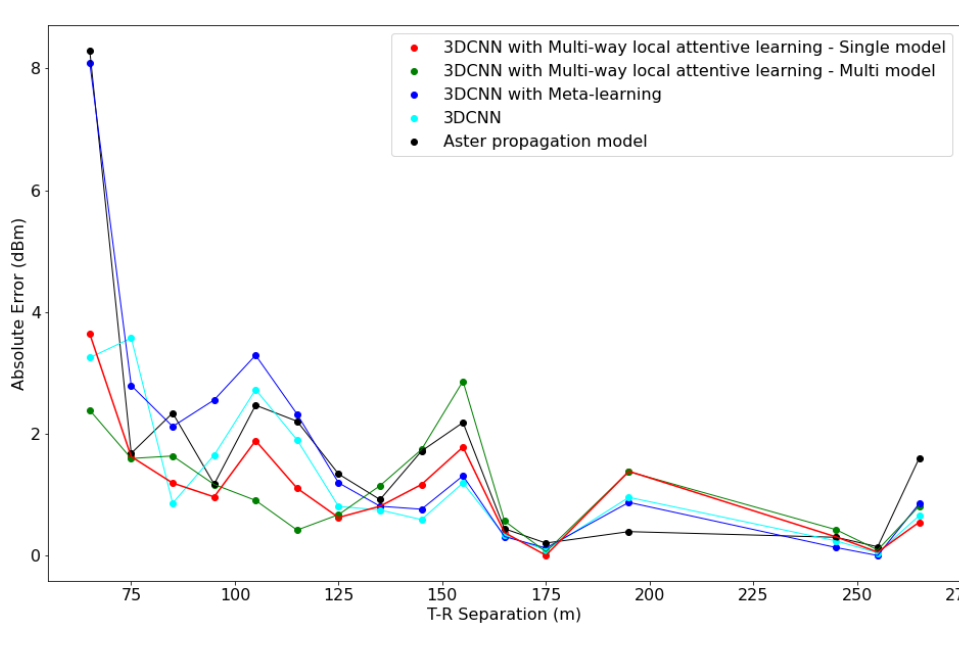
Figure 5. Absolute Error Comparison—LoS.